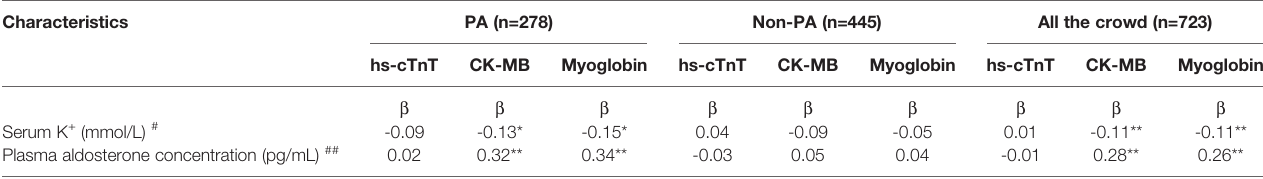
TABLE 3 | Multivariate linear regression between myocardial injury markers and biochemical characteristics in the study participants. Characteristics